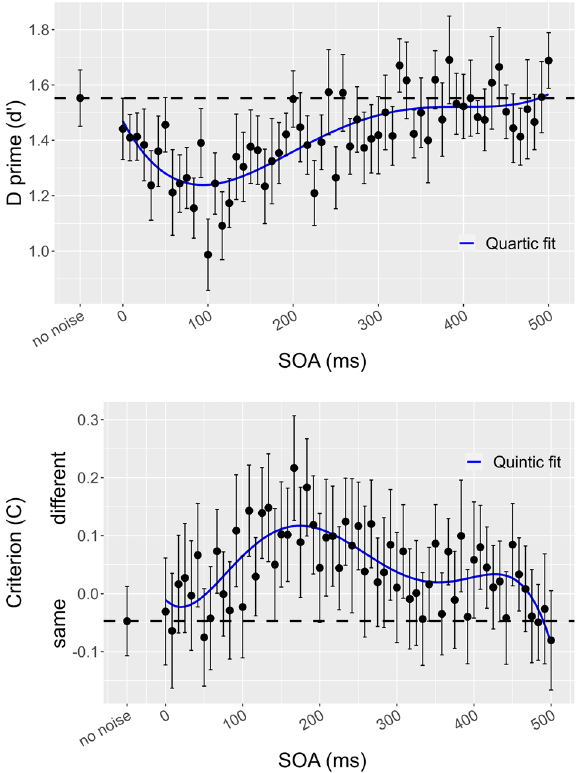
Figure 3. The upper panel shows d’ as a function of SOA. The lower panel shows the response criterion as a function of SOA. Black dots represent mean values with standard errors. The black dashed line represents the baseline no-noise condition. The solid blue line represents the polynomial fit.